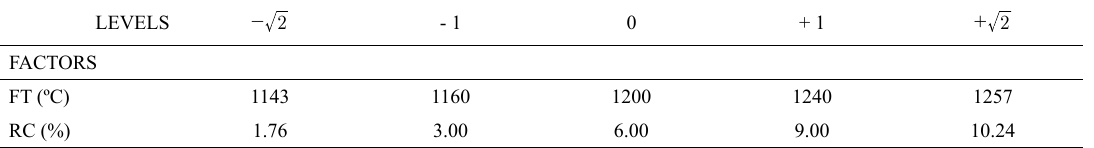
Table 1. Analyzed factors (FT – Firing temperature; RC – Residue content), their levels and coded values.